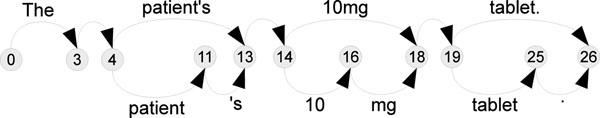
A bounded lattice representing a sentence’s segmentations An example of a bounded lattice representing a sentence’s segmentations.